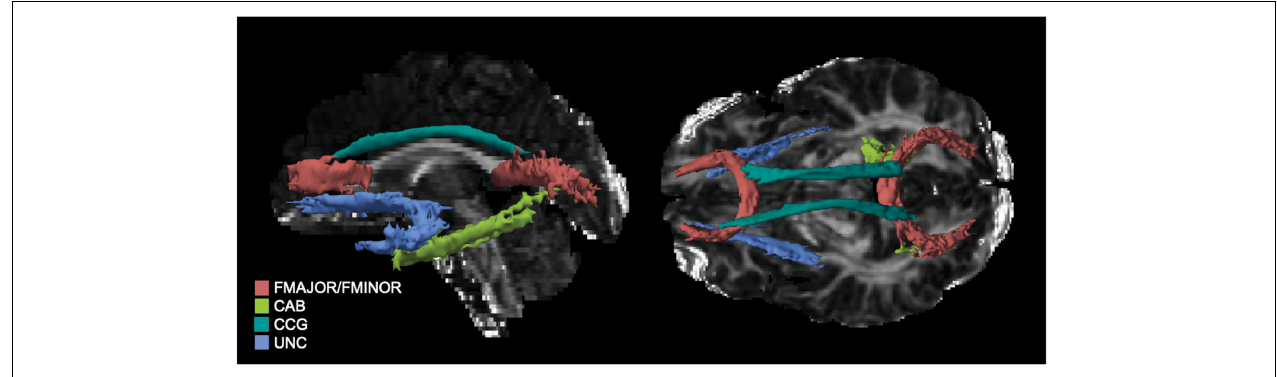
FIGURE 1 | Tracts of interest as reconstructed in TRACULA for a representative participant. UNC, uncinate fasciculus; CCG, anterior cingulum; CAB, posterior, FMAJOR, forceps major; FMNIOR, forceps